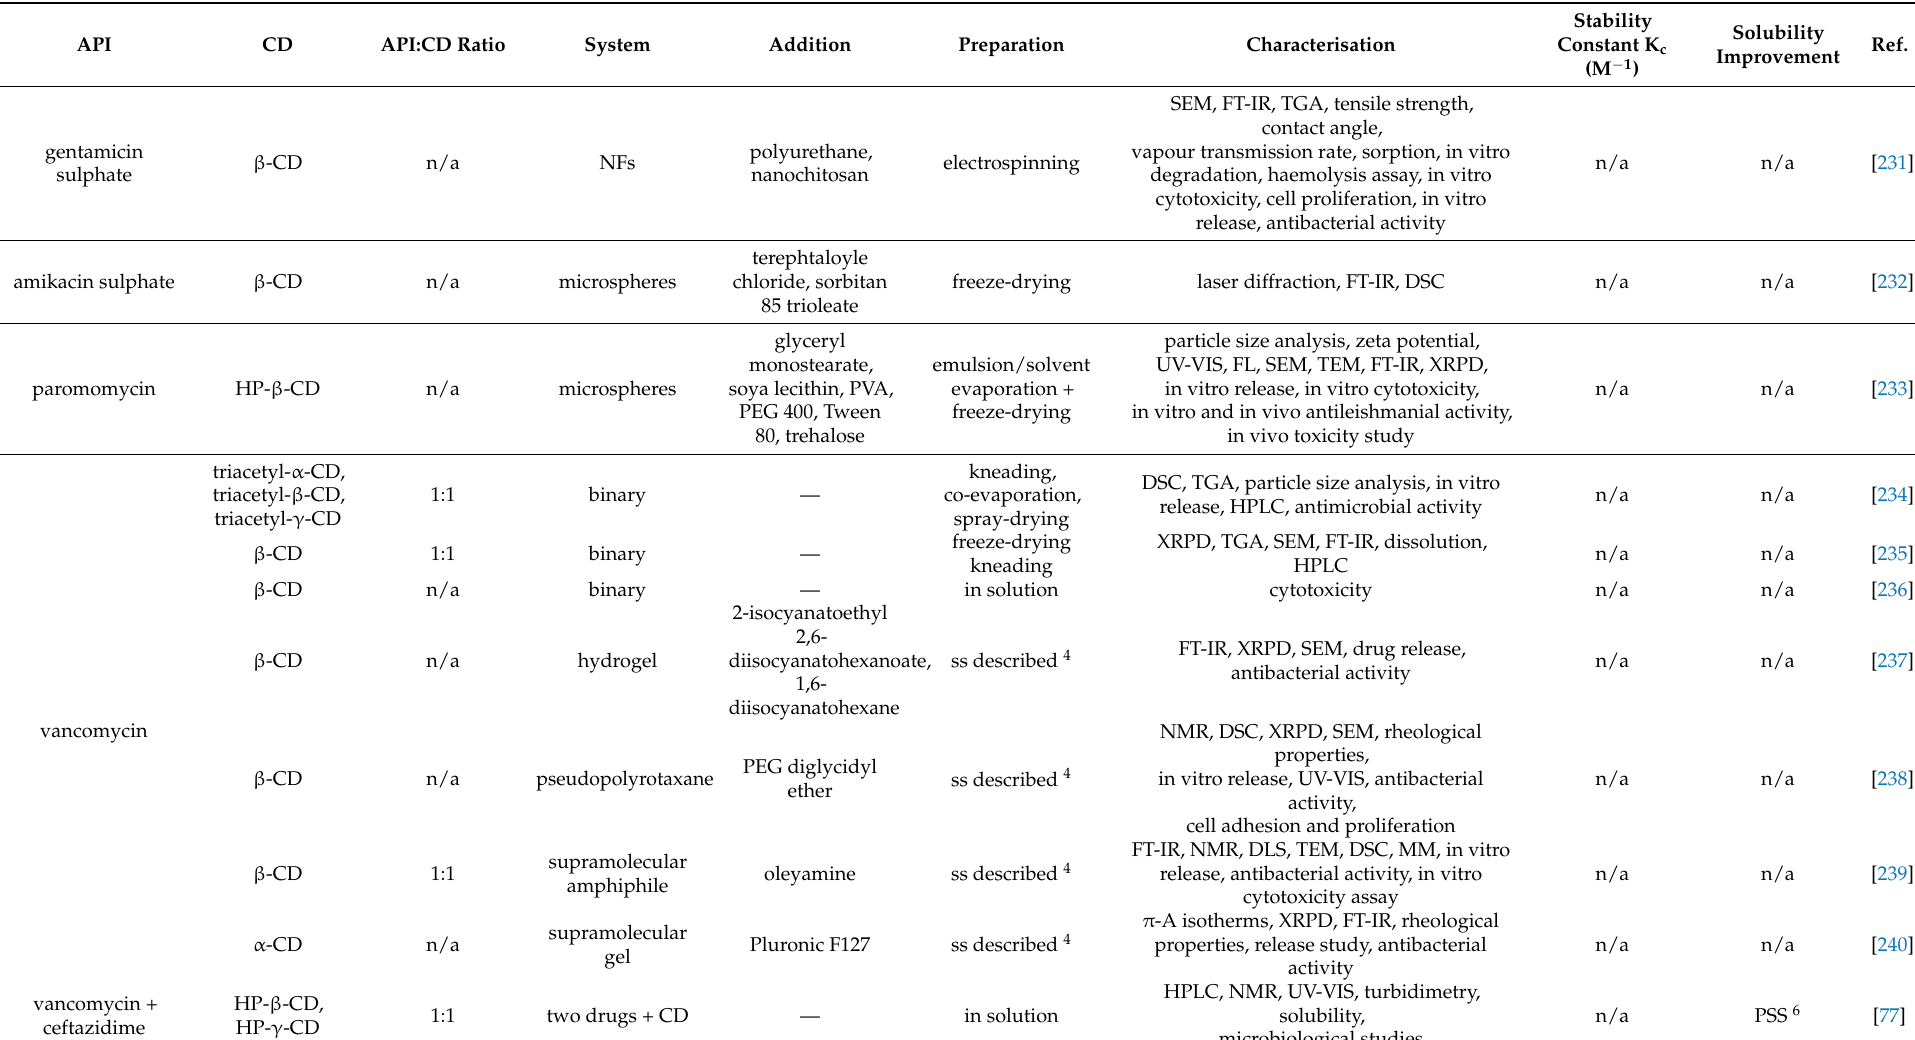
Table 8. Detailed information of complexes of other antibacterial drugs on the types of CDs used, methods of complex preparation, and characterisation techniques